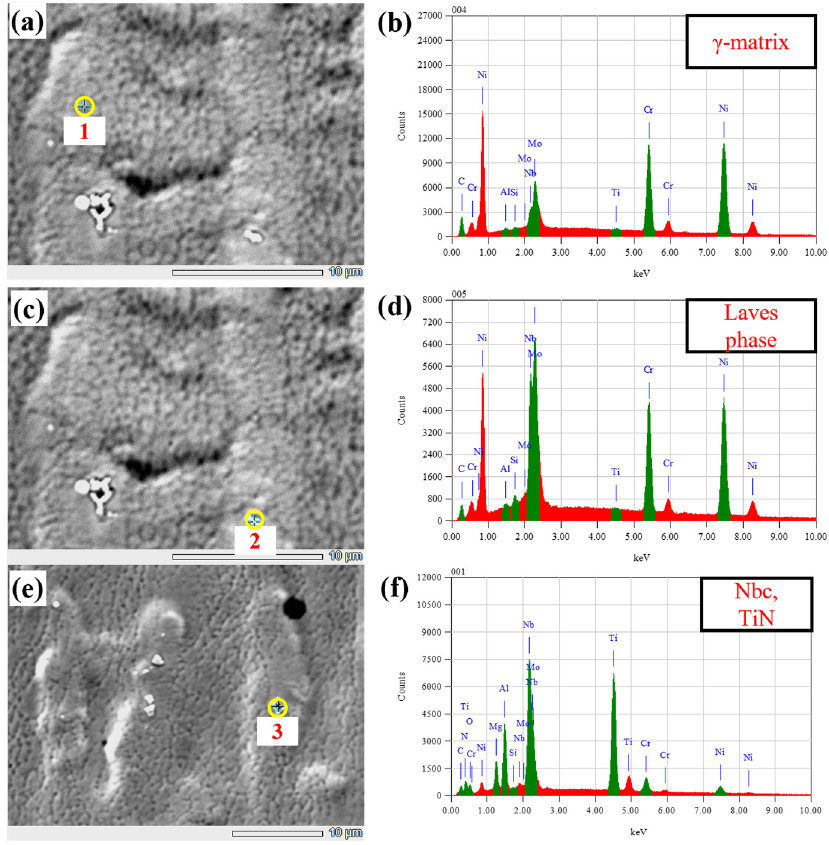
Figure 10. Backscattered electron image and EDS results of different phases: ( a , b ) matrix, ( c , d ) Laves phase and ( e , f ) MC carbide.